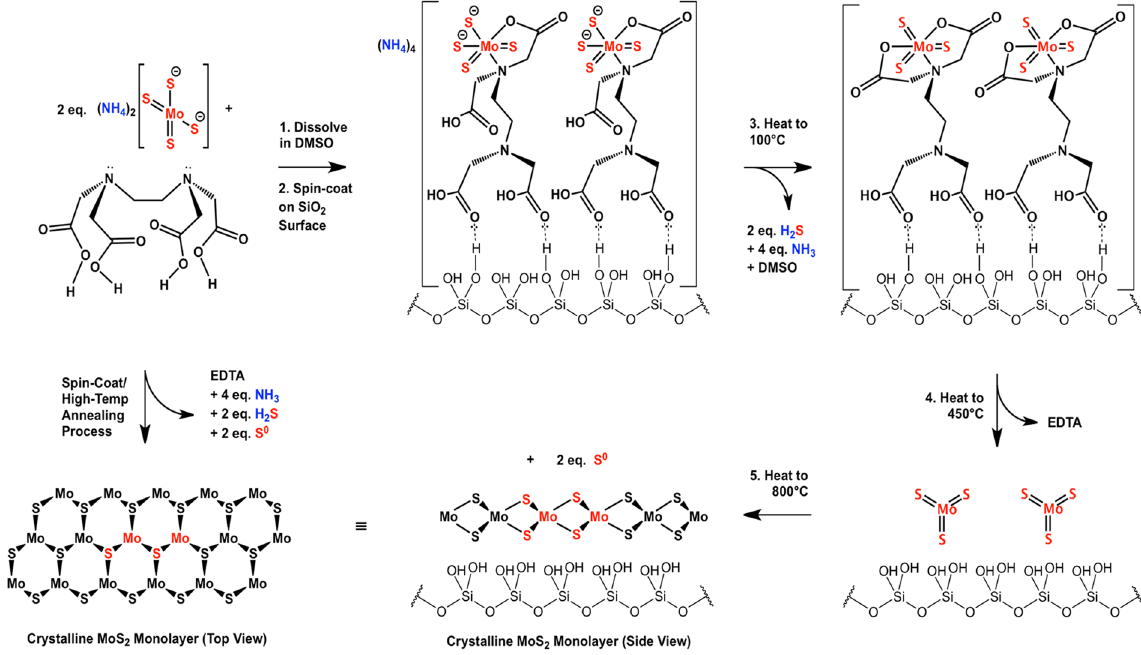
Figure 3. Mechanism for the synthesis of crystalline MoS 2